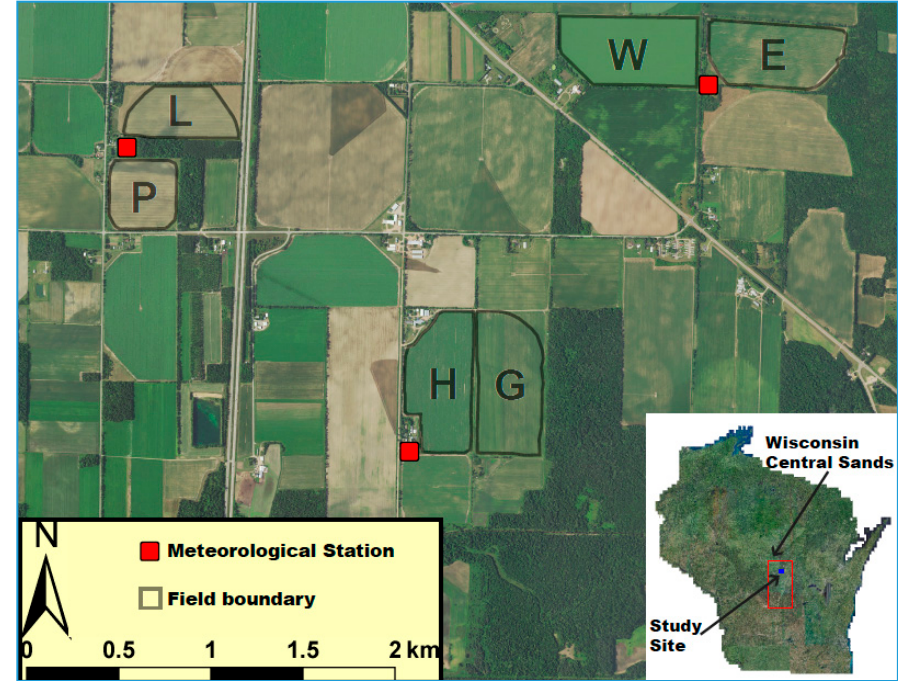
Figure 1. Study site at the Central Sands region in the Wisconsin, U.S.A., as adapted from Nocco et al., 2019. Georeferencing conducted using 2013 National Agriculture Imagery Program data for Portage County, WI.